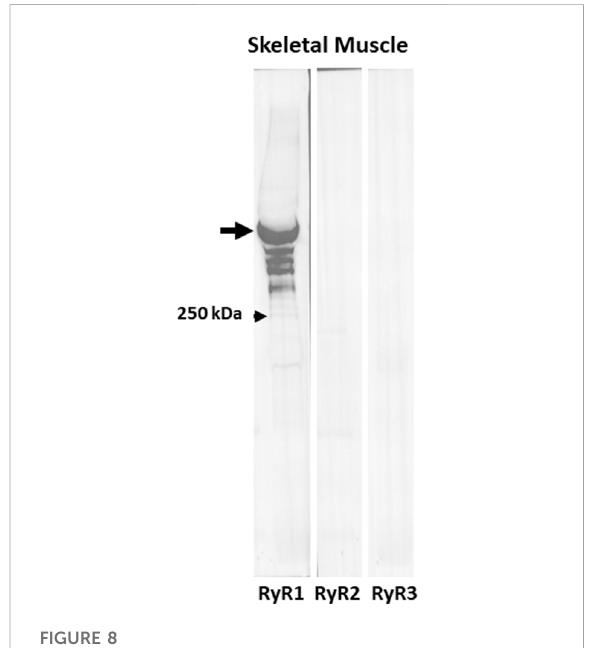
FIGURE 8 RyR1 but not RyR2 or RyR3 are expressed in fast twitch skeletal muscle. Immunoblots of extracts of Tibialis anterior muscles with antibodies to RyR1, RyR2, and RyR3. Only anti-RyR1 shows a strong band at ~550